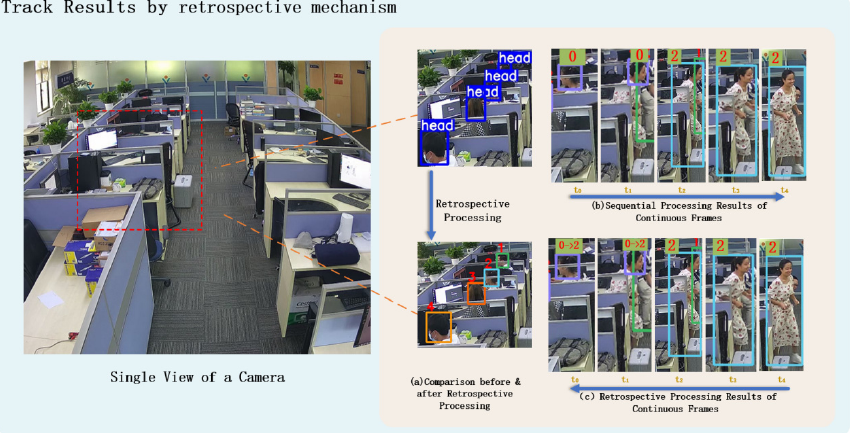
Figure 15. Optimization of head tracking results with the addition of the retrospective